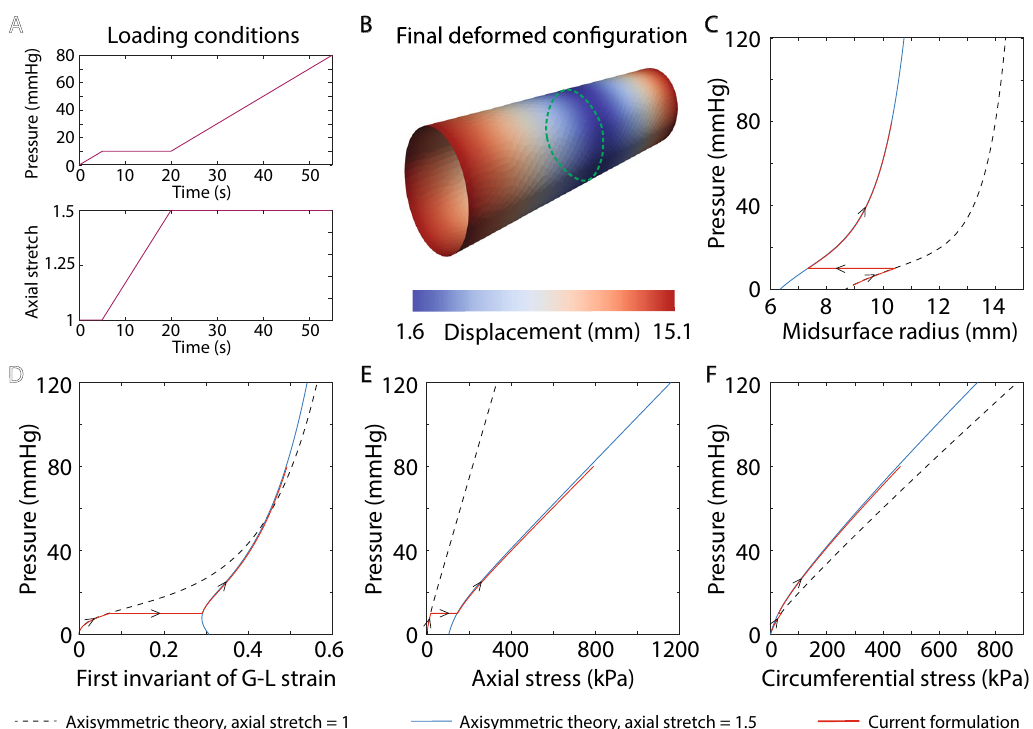
Figure 4. Verification of shell formulation for a cylindrical tube. ( A ) Shows the loading conditions, namely pressurization to 10 mmHg, followed by an extension to an axial stretch of 1.5 at constant pressure and, then a subsequent pressurization to 80 mmHg. ( B ) Shows the final deformed configuration at 80 mmHg. ( C – F ) Plot the evolution of midsurface radius, first invariant of Green-Lagrange strain tensor, axial stress, and circumferential stress,